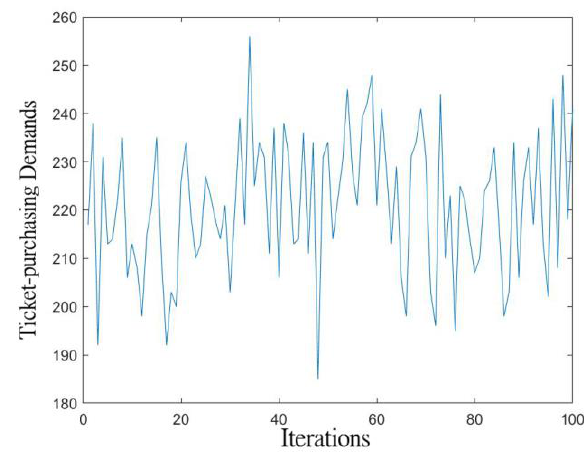
Figure 6. Simulation circulation